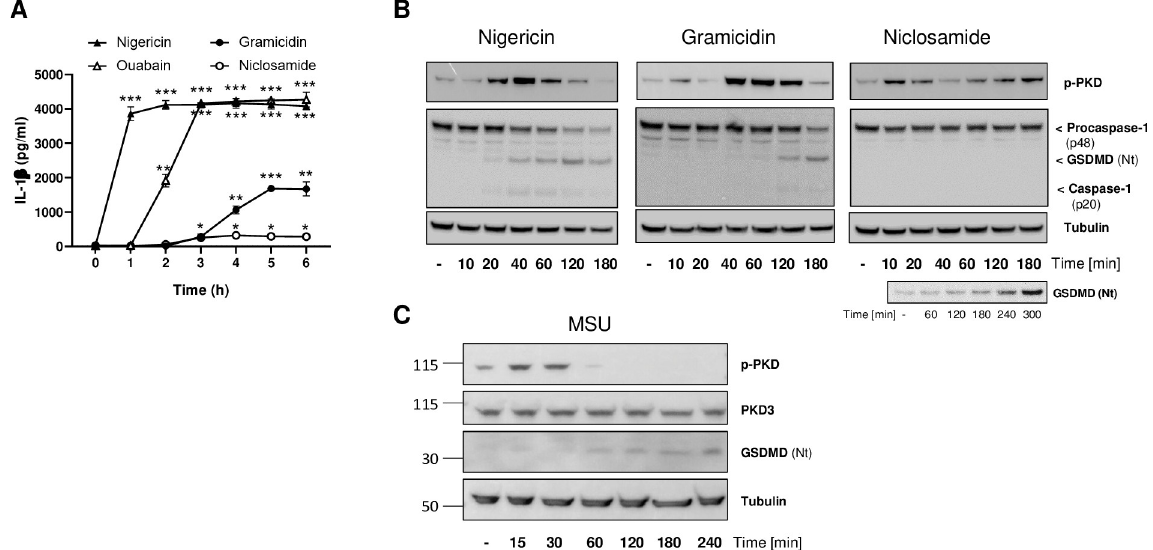
Fig 1. PKD auto-phosphorylation coincides with NLRP3 activation. (A) IL-1 β secretion measured using THP-1 cells primed with 100 nM PMA and stimulated with nigericin (15 μ M), ouabain (1 uM), gramicidin (10 uM) or niclosamide (1uM) after the indicated time course. This is one of two experiments with similar results. Statistical significance was calculated with a Student T-test. (B) Stimulation time course using THP- 1 cells treated with either nigericin, gramicidin, or niclosamide followed by whole cell lysates analysis by immunoblotting to detect PKD activation (auto-phosphorylation) and NLRP3 inflammasome activation (caspase-1 and gasdermin D cleavage). Tubulin levels were used as loading controls. This is one of two (gramicidin) or three (nigericin, niclosamide) experiments with similar results. An additional experiment with a prolonged time course in the presence of nigericin was implemented to allow for detecting NLRP3 activation (lower panel). (C) Stimulation time course using THP-1 cells treated with MSU crystals at 250 μ g/ml followed by whole cell lysates analysis as done in B; this is one of two experiments with similar results. Total PKD3 levels (reported to be the only PKD family member expressed in THP1 cells [33]) were also monitored.